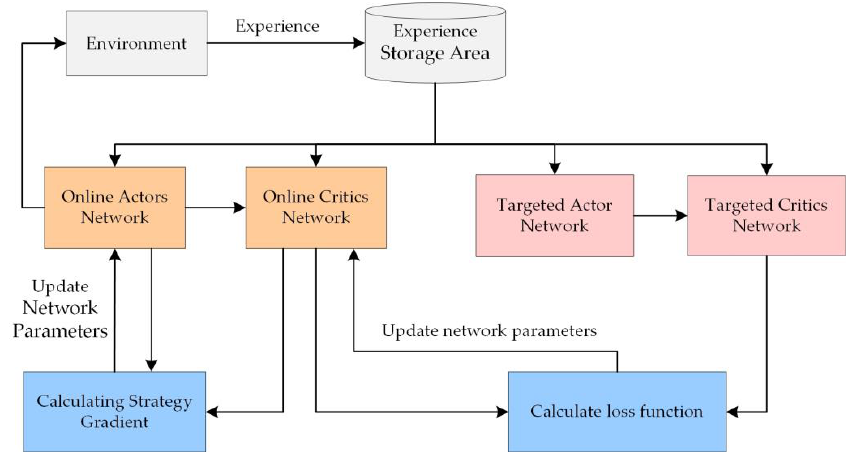
Figure 9. The structure of the DDPG algorithm.